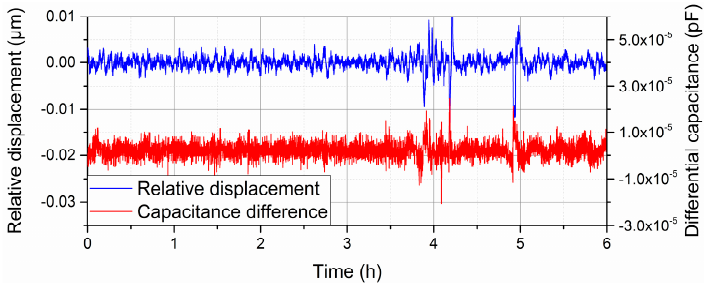
Figure 8. Long-time stability of the differential capacitance value under the position locking statement.